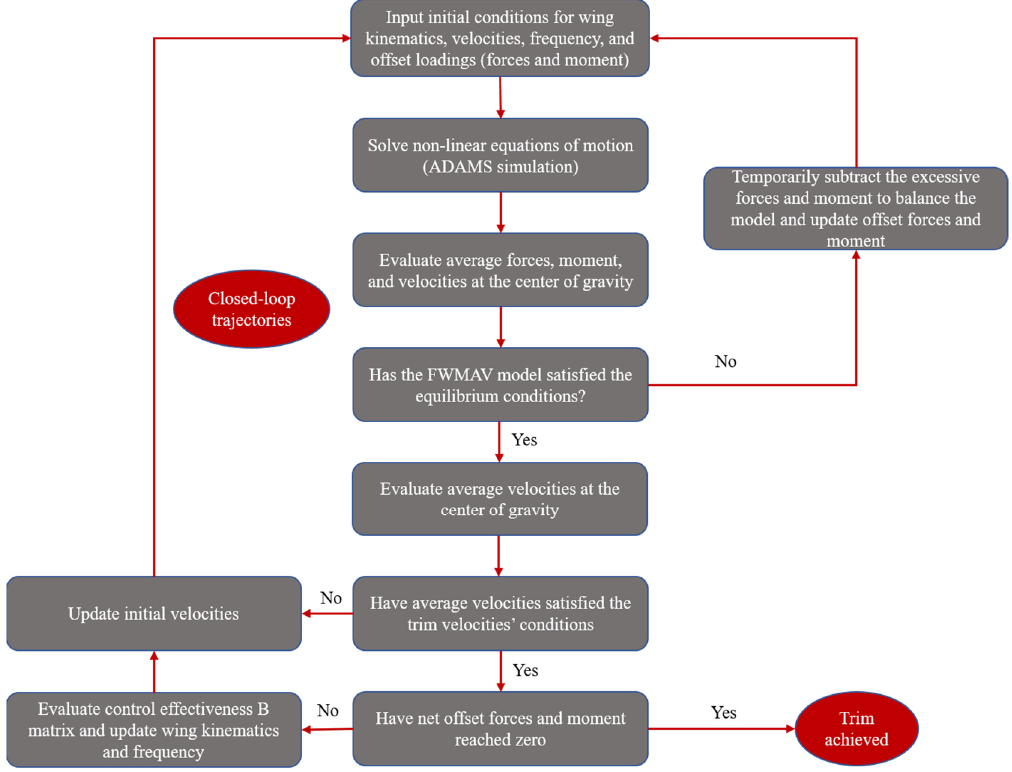
Figure 4. Gradient-based trim search algorithm.